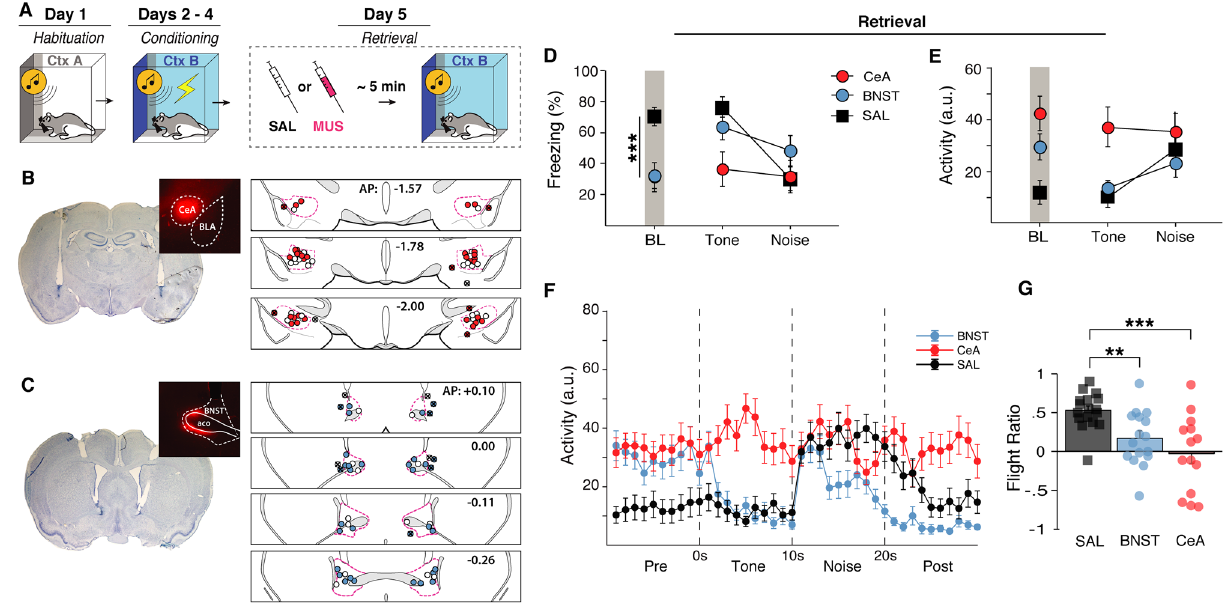
Figure 6. Pharmacological inactivation of either the BNST or CeA disrupts flight-like behavior. ( A ) Behavioral design. Histological summary of CeA ( B ) and BNST ( C ) cannula placements with representative thionin- stained sections and drug spread with fluorescent muscimol. Labeled anterior–posterior coordinates are relative to bregma. ( D ) averaged freezing data showing that CeA and BNST animals both showed reduced baseline freezing. BNST animals increased freezing to tone presentation and remained at higher freezing levels during white noise. CeA animals remained at low levels of freezing during the SCS. ( E , F ) averaged activity levels during ratio ( G ). All data are represented as mean ± SEM pooled across sex [CeA ( n = 14); BNST ( n = 16); SAL ( n = 16)]; *, **, and *** denote p < 0.05, p < 0.01, and p < 0.001,